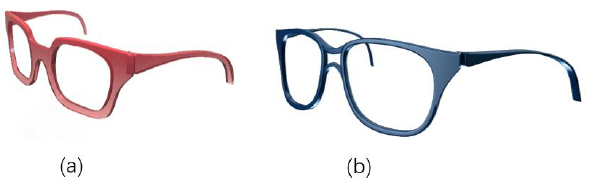
Figure 16. ( a ) Detail design of eyewear1;( b ) Detail design of eyewear 2.